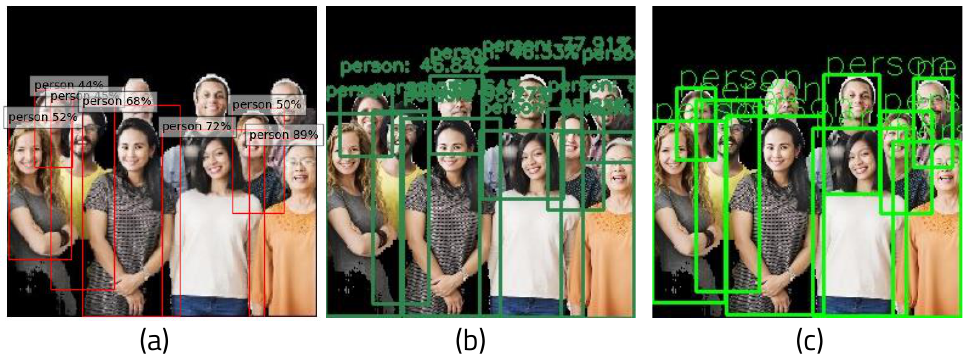
Figure 24. Results for different frameworks: ( a ) SSD, ( b ) MobileNet, and ( c ) Faster